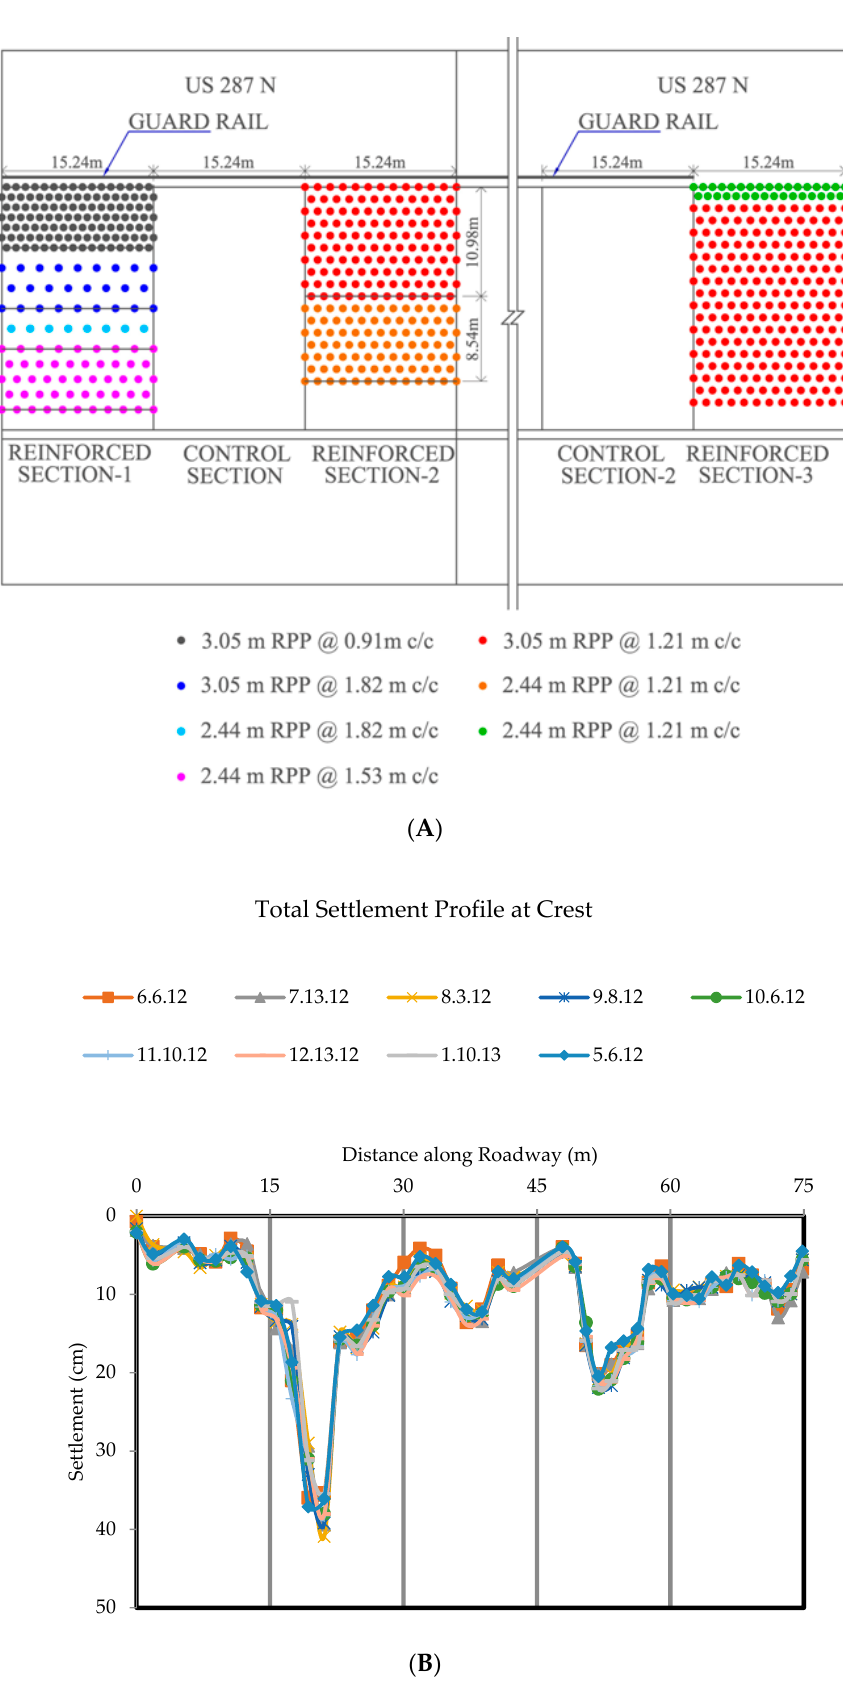
Figure 1. Performance of US 287 slope ( A ) the layout of RPP and ( B ) total settlement profile at the crest of the slope [11].